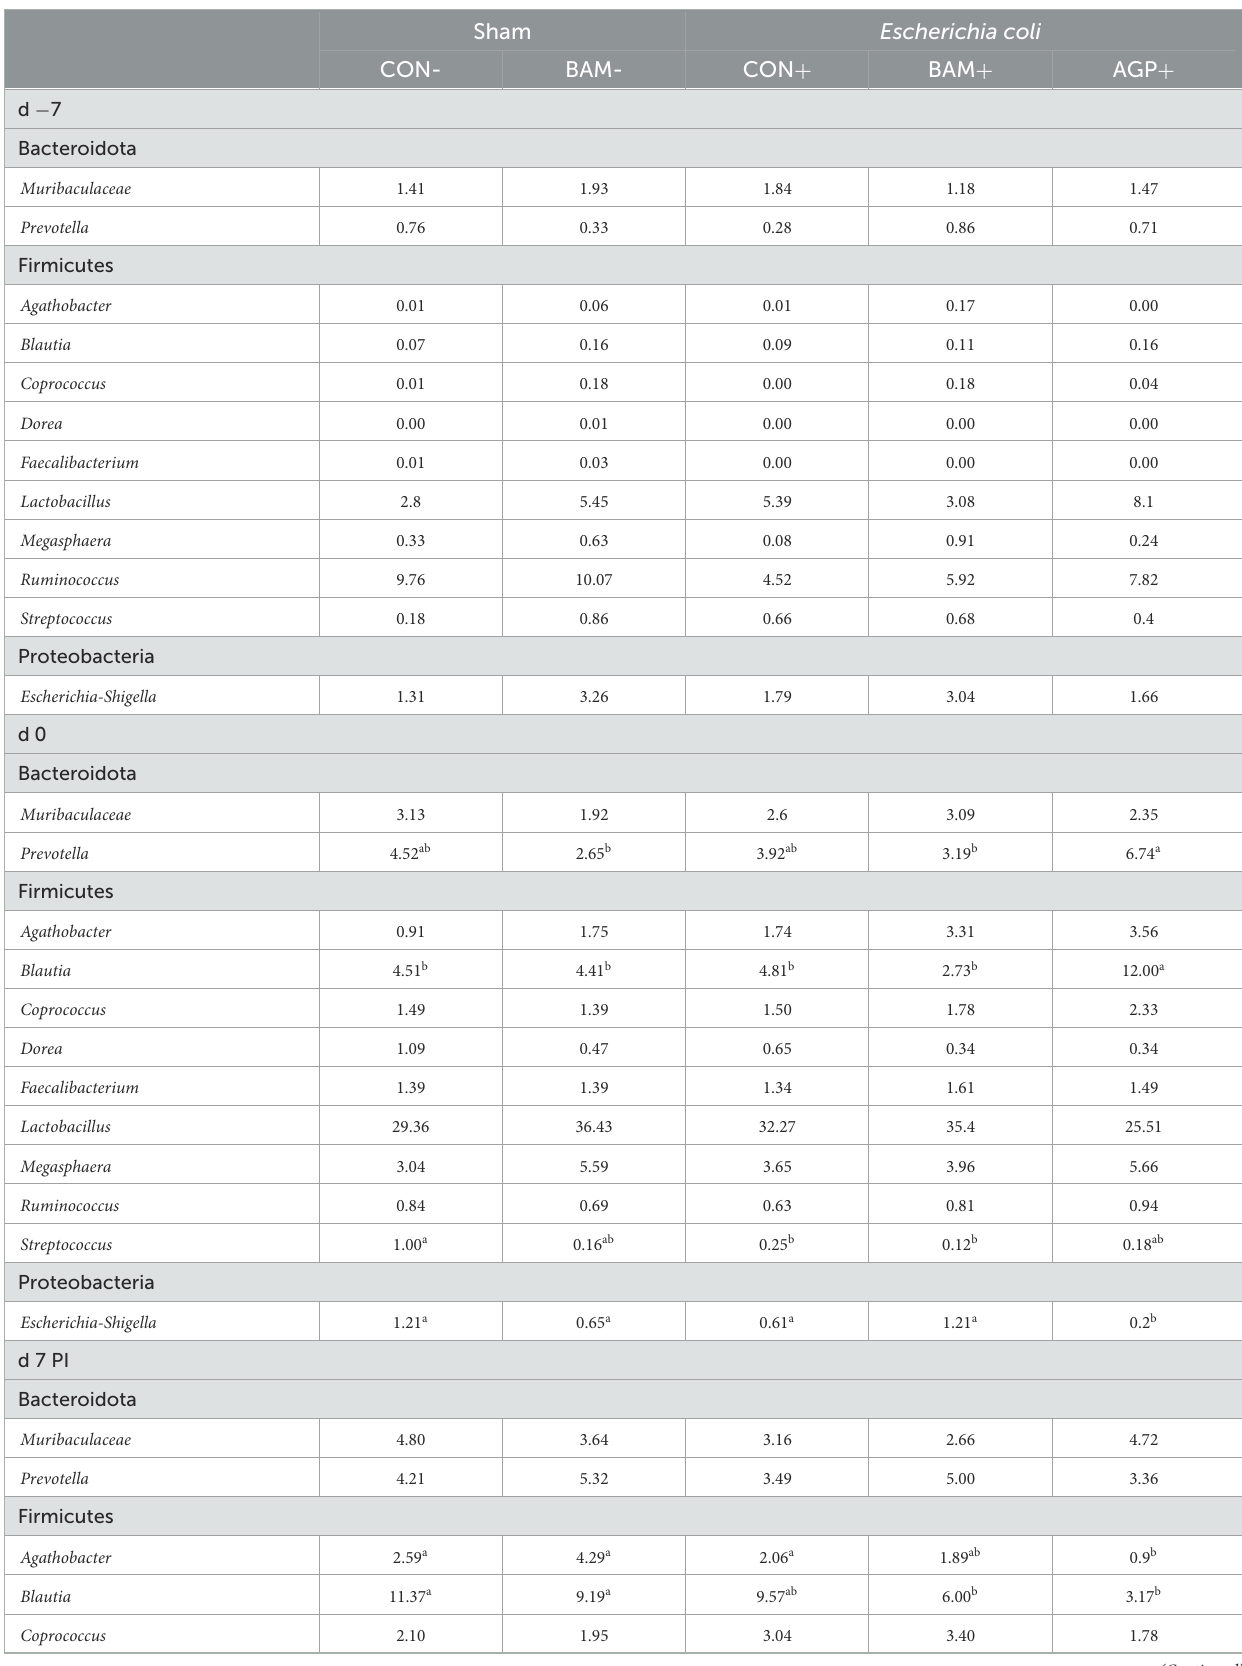
TABLE 5 Relative abundance (%) of most abundant genera from Bacteroidota, Firmicutes, and Proteobacteria in feces of weaned pigs fed control (CON) diet or diets supplemented with Bacillus amyloliquefaciens (BAM) or antibiotics (AGP). Sham Escherichia coli CON- BAM- CON + BAM + AGP